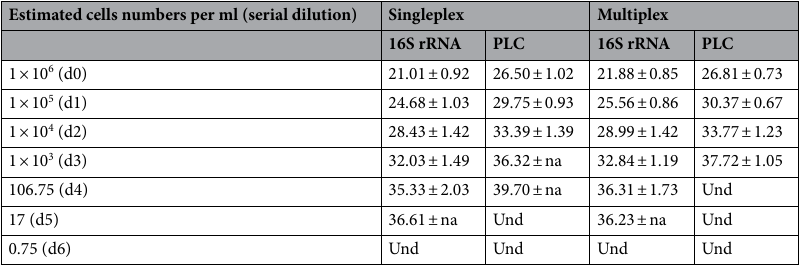
Table 3. Determination of the detection limit for B. cereus 3A* using qPCR C T values. *Tenfold serially diluted (d0–d6) B. cereus 3A. These data are averaged across 2 separate runs, na Not averaged: only one signal was read, Und . Undetermined, no signal was observed; 16S rRNA 16S rRNA, PLC phosphatidylcholine-specific phospholipase C.